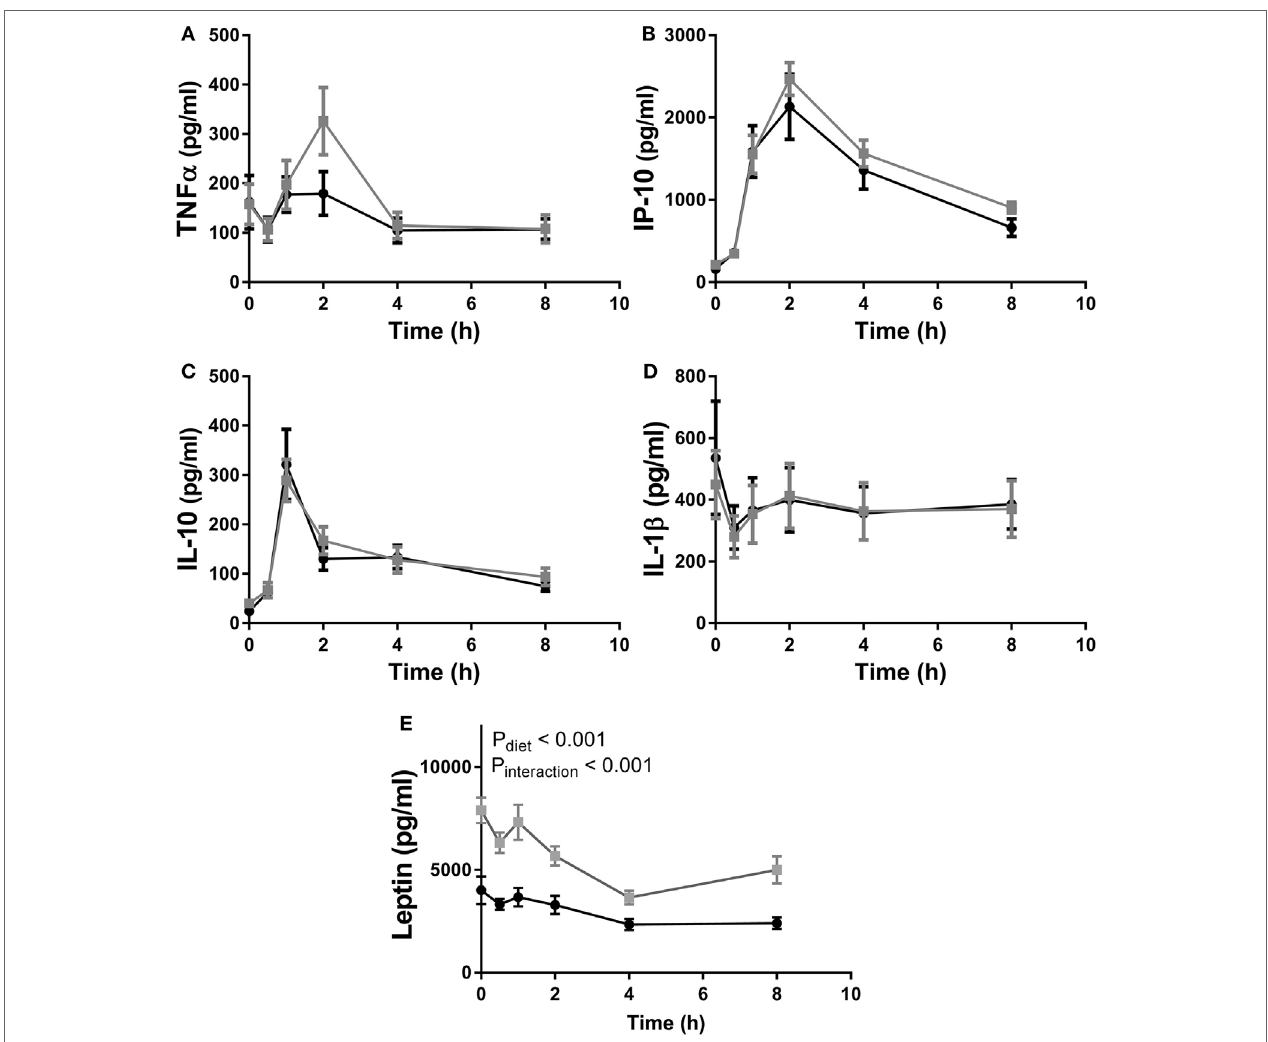
FigUre 3 | Plasma (a) TNF α , (b) IP10, and (c) IL10 increased after lipopolysaccharide (LPS) administration in both chow (black circles) and free-choice high-fat high-sugar diet (light squares) animals, whereas (D) IL1 β levels remained stable during the time course of the experiment. Diet had no effect on plasma cytokine levels. An interaction effect between diet and LPS was observed in (e) serum leptin levels. Mixed–repeated measures ANOVA followed by Bonferroni’s multiple comparisons post hoc analysis was used to determine significant differences in cytokine levels between different time points and diet groups. Data are presented as mean ( n = 10) ±